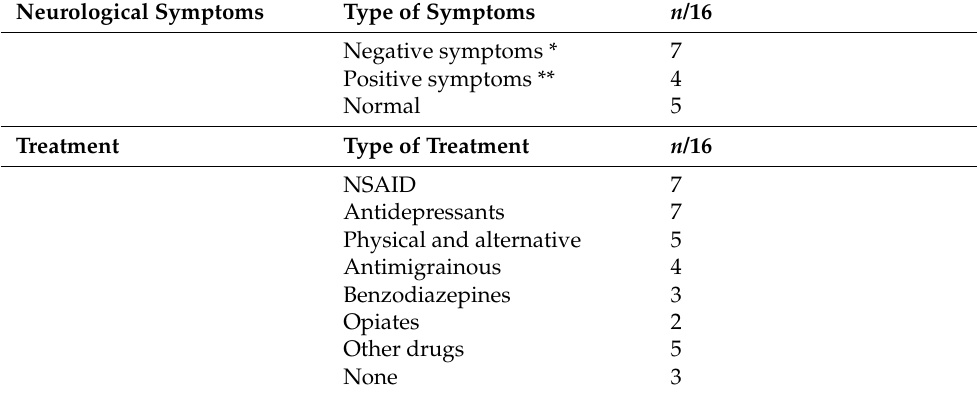
Table 1. Pain-associated neurological symptoms and treatment in FM patients.